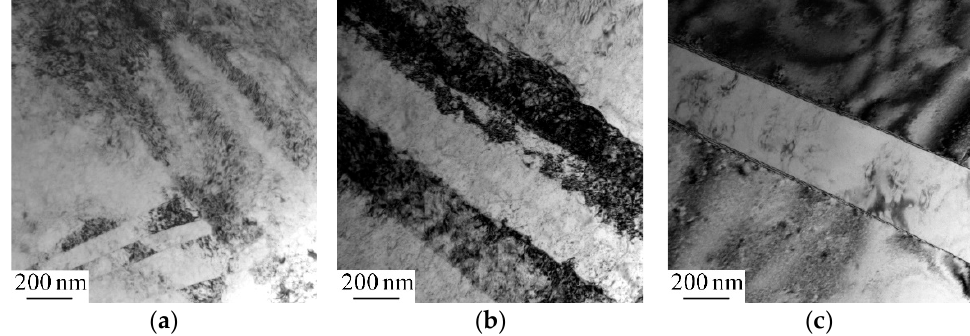
Figure 5. TEM bright-field images of the microstructure of the CP-Ti sample after the UIT processing, TEM images were obtained at depths of 10 ( a ) and 50 ( b , c ) μ m below the surface of the sample.